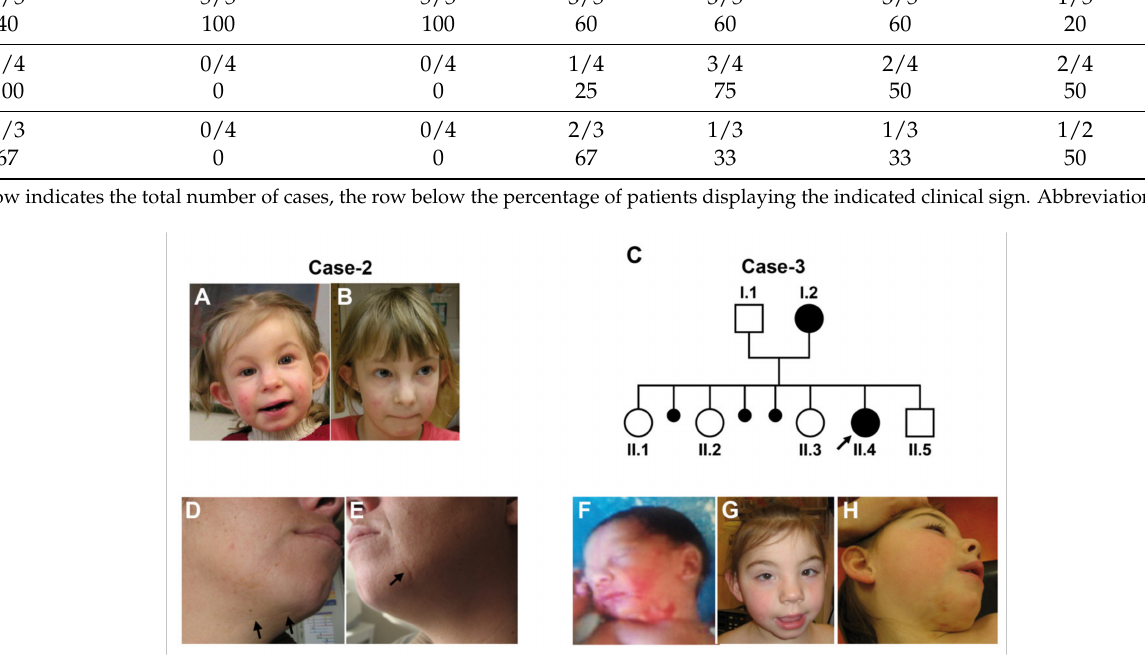
Figure 1. Linear skin lesions in LSDMCA2 patients. ( A , B ) Case-2. She had asymmetric face with limited eyelid closure, linear skin defects on face and neck, which became less